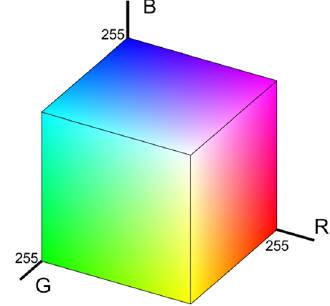
Figure 2. RGB color model representation.